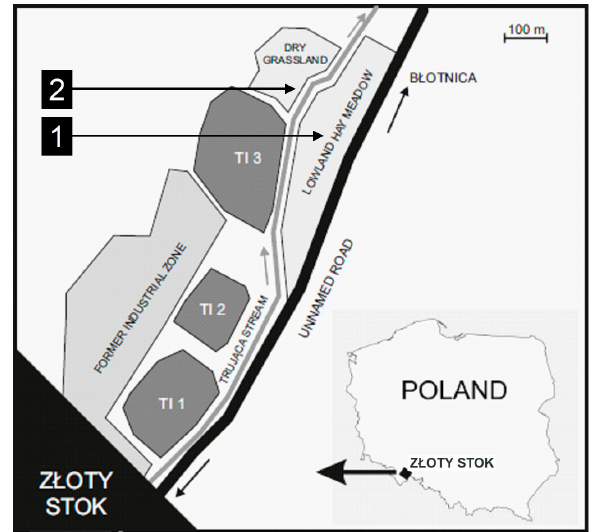
Figure 1. Location of the sites 1 and 2 under study. 1—Lowland hay meadow flooded by tailings. 2—Dry grassland on the plateau built of tailings. TI 1, TI 2, TI 3—tailings impoundments No 1, 2, 3, respectively. Błotnica—the name of a nearby village.